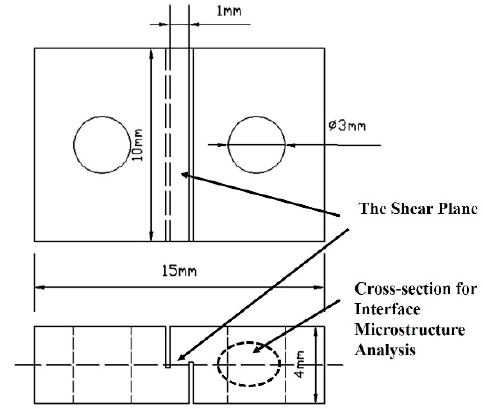
Figure 2. Schematic image of the tensile-shear strength test samples (unit: mm).